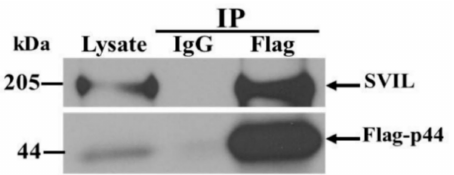
Figure 6. Interaction between the hOAS1 p44 isoform and endogenous full-length SVIL in A549 cell extracts. Human A549 cells were transiently transfected with plasmid DNA expressing the 3xFlag-tagged full-length hOAS1 p44 isoform. At 48 h post transfection, cell lysates were collected and incubated with anti-Flag antibody-conjugated agarose beads. Non-specific IgG conjugated agarose beads were used as the negative control. After co-immunoprecipitation, protein complexes were resolved by SDS-PAGE, transferred to a nitrocellulose membrane and detected by anti-Flag and anti-SVIL